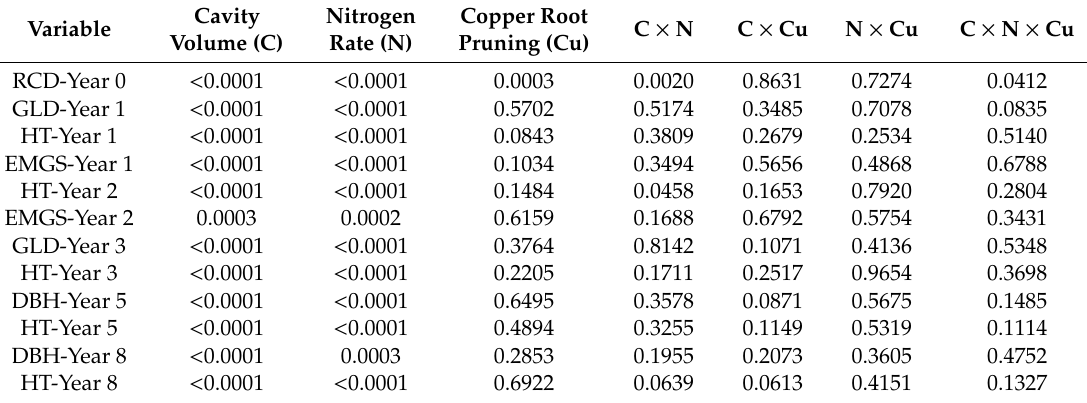
Table 2. p -values for the e ff ects of nursery treatments (cavity volume, N rate, and Cu root pruning) and their two- and three-way interactions on seedling morphological variables assessed at outplanting (Year 0) and up to eight years after outplanting (Year 8) using analysis of variance. The measured morphological variables are as follows: RCD, root collar diameter; GLD, ground-line diameter; HT, height; EMGS, percent emergence from the grass stage; and DBH, diameter at breast height.